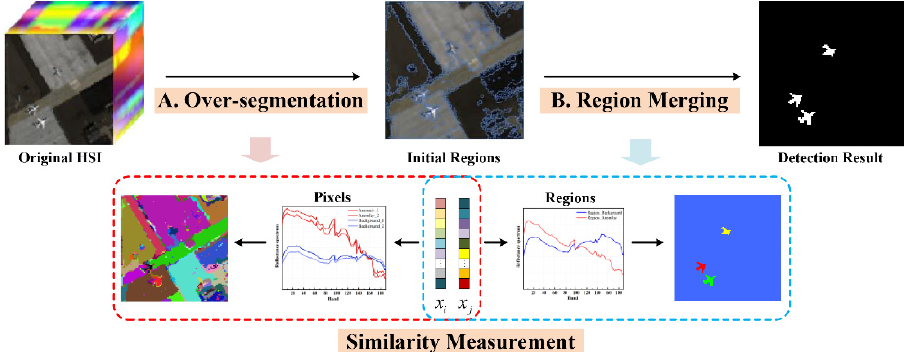
Figure 1. Flowchart of the proposed algorithm.